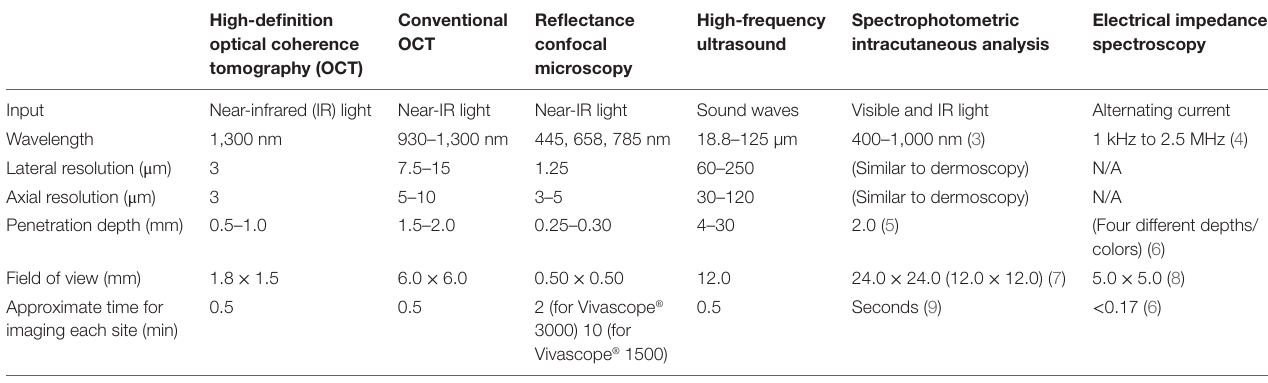
TaBle 1 | Comparison of imaging parameters for non-invasive techniques in